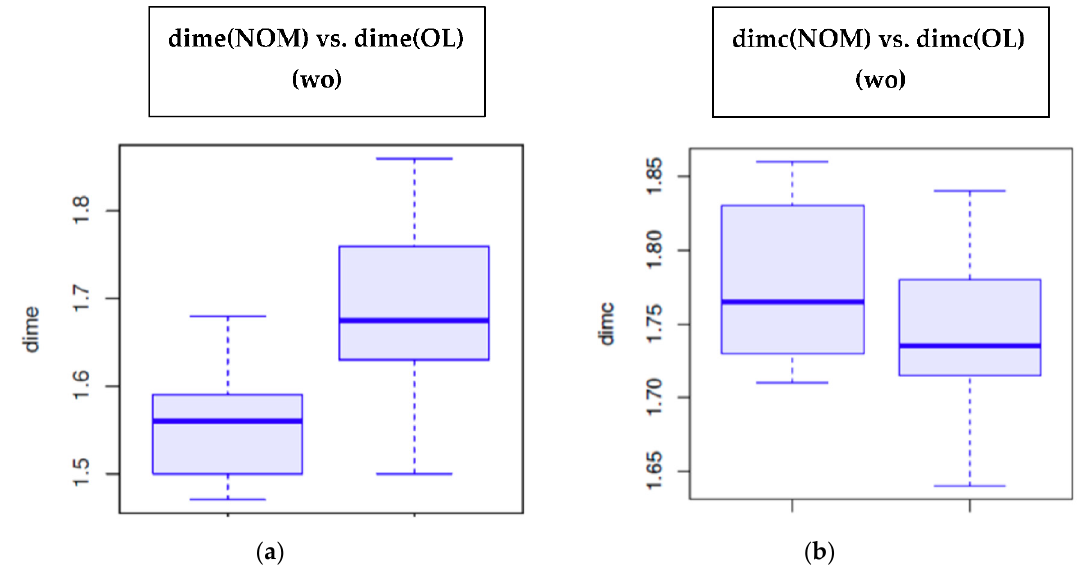
Figure 3. The values of: ( a ) dime OL vs. NOM; ( b ) dimc OL vs. NOM. 3.3. Study of the Effect of the Types of Dysplasia on the Values of Dime and Dimc equal to 1.65 ± 0.10 was obtained. On the other hand, for those subjects with a low level of dysplasia, a mean dime of 1.64 ± 0.08 was obtained, while for the patients with a high level of dysplasia, a mean dime equal to 1.79 ± 0.08 was obtained (Table 3). Significant differences were observed between the non-dysplasia vs. high-grade ( p = 0.0156) and low-grade vs. high-grade ( p = 0.0049) groups. In relation to dimc , there were no statistically significant differences for the different degrees of dysplasia. No differences were found between ages in the different subgroups of dysplasia, nor in the type of sample ( p = 0.692 and p = 0.087, respectively). Moreover, no statistical correlation was found between the age and the dime, nor with dimc ( p = 0.115 and p = 0.992, respectively). No differences were found between the genders and the dime or dimc ( p = 0.797 and p = 0.223, respectively). Table 3. Fractal dimension for dime and dimc according to the degree of dysplasia in the OL group. Level 1 without Dysplasia Level 2: Low Level of (Count = 13)